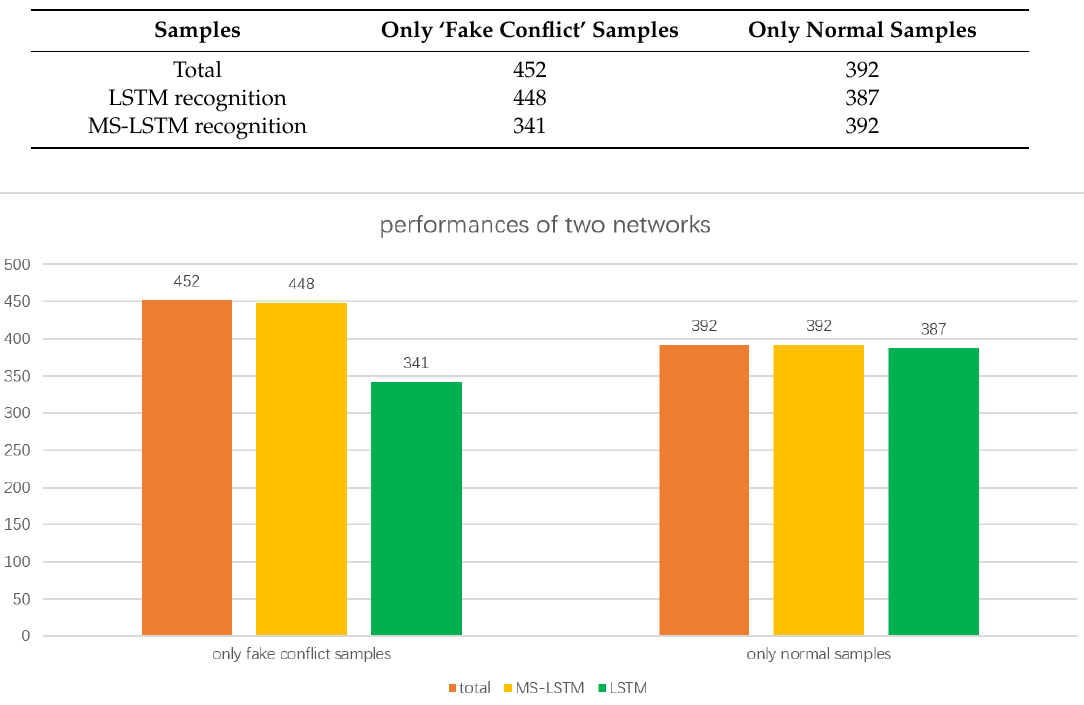
Table 9. Performances of the 3 networks only using fake conflict samples.